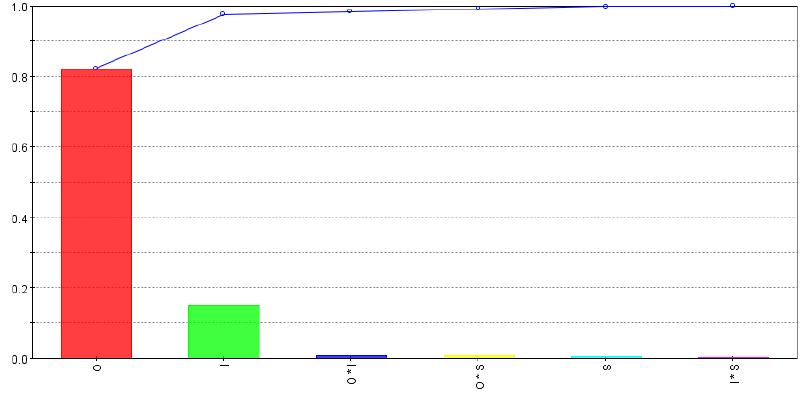
Figure 9. Relative strength of input variables and their interactions for bottom width error ( 𝜖 𝑏 ).